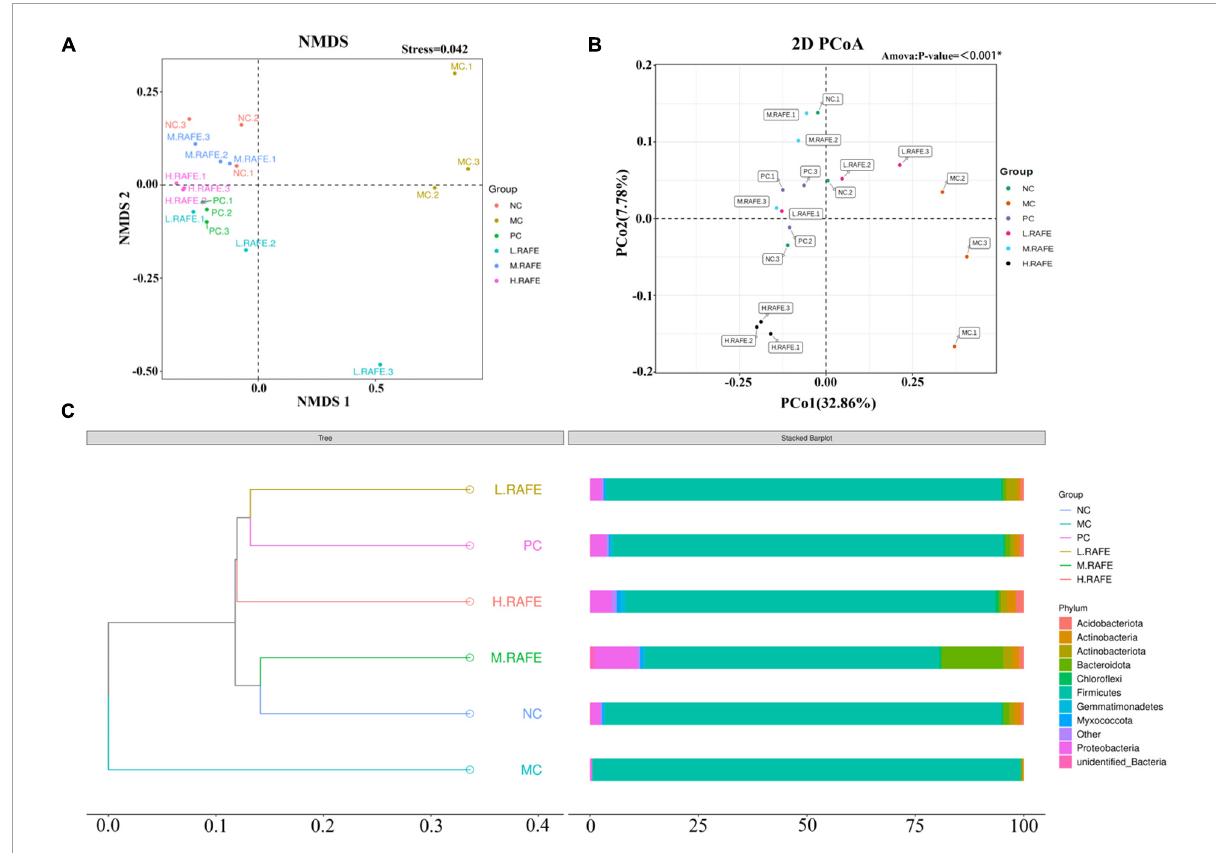
FIGURE7 Effect of RAFE on beta diversity of mice intestinal microorganisms. (A) Non-metric multidimensional scaling analysis based on OTU levels, (B) 2D plot of unweighted UniFrac distance-based principal co-ordinates analysis, where closer sample distances indicate more similar species composition structures, and (C) unweighted pair-group method with arithmetic mean clustering tree based on unweighted UniFrac distances. n = 3